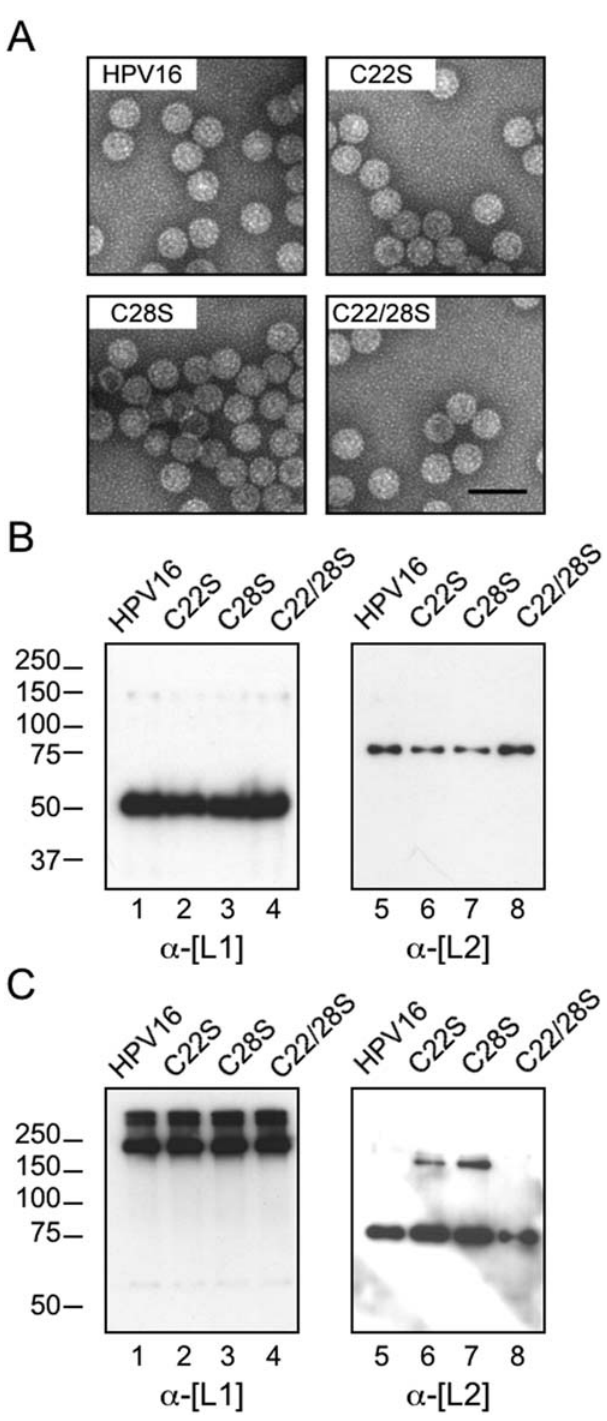
Figure 2. Characterization of L2 cysteine mutant virions. (A) Morphology of the L2 wild type and cysteine mutant virions. CsCl- purified virion preparations were negatively stained and visualized by transmission electron microscopy. Scale bar represents 100 nm. (B) Reducing and denaturing SDS-PAGE of wild type and mutant L2- containing virions, immunoblotted for L1 (left panel) and L2 (right panel) capsid proteins. Note the absence of L2 size shift for any of the cysteine mutants, suggesting no large cysteine modifications are present. (C) Analysis of HPV16 L2 wild type and mutant virions by denaturing SDS-PAGE under non-reducing conditions. L1 immunoblot (left panel) shows disulfide-linked multimers of L1 for wild type and